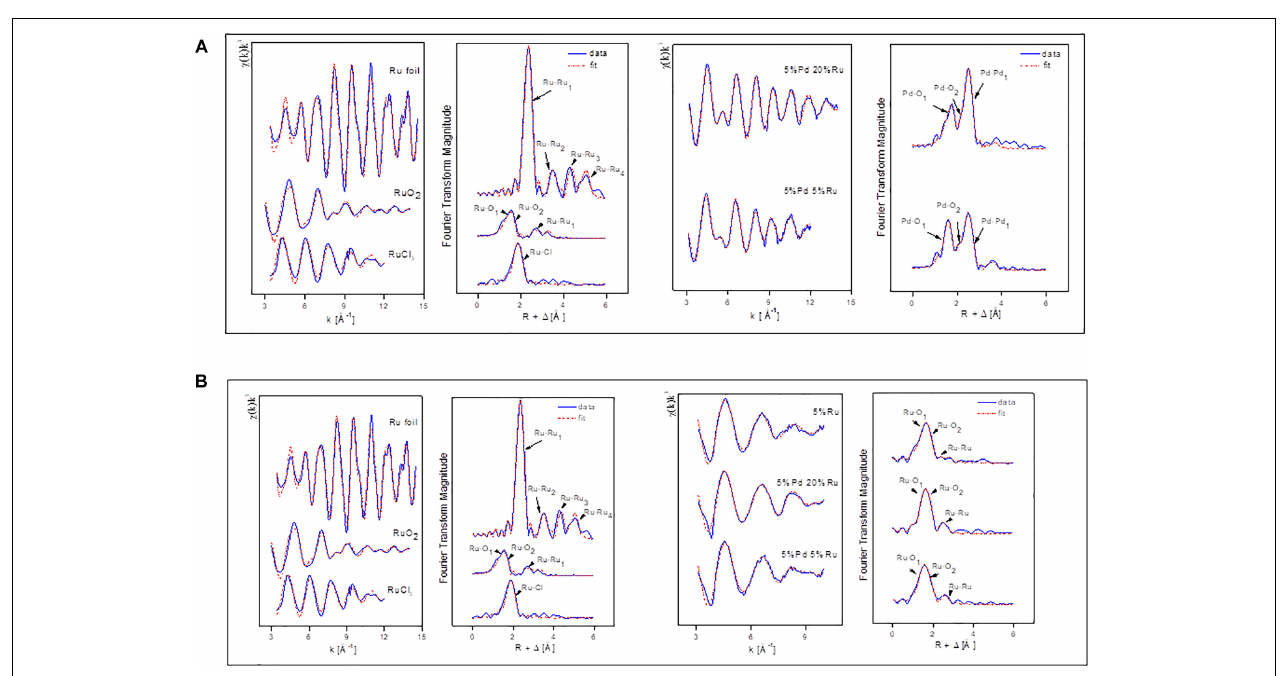
FIGURE 5 | (A) EXAFS spectra of Pd foil and Pd-Ru biogenic NPs samples as well as their corresponding FT. (B) EXAFS spectra of Ru foil, RuCl 3 , and Pd-Ru biogenic NPs samples as well as their corresponding FT.